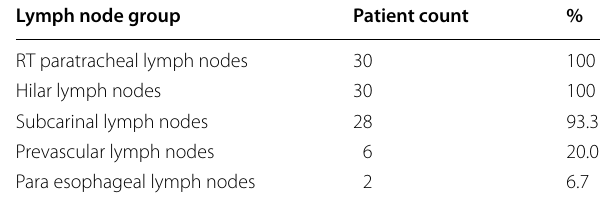
Table 1 Lymph node distribution in the sarcoid patients